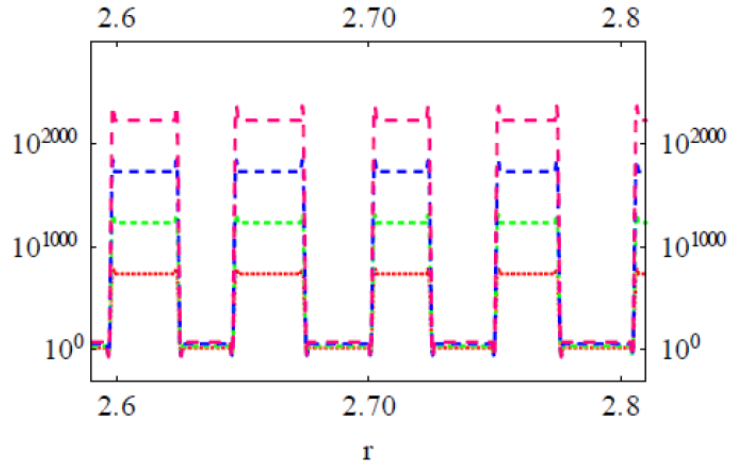
Figure 10. Numerically computed energy versus reaction coordinate plots of Equation (1). Col in Col cluster (top panel) and Col in lipid cluster (bottom panel). In both panel figures there are four curves representing energies of four SCI orders first, second, third, fourth (bottom to top). Here a = 1 nm, q Col q PC = 10 − 2 e 2 . The back-and-forth transitions for any SCI order shown here happen between two energy states; the pattern of the transition is shown (from lower to higher energy state transition) in expanded scale plots in Figure